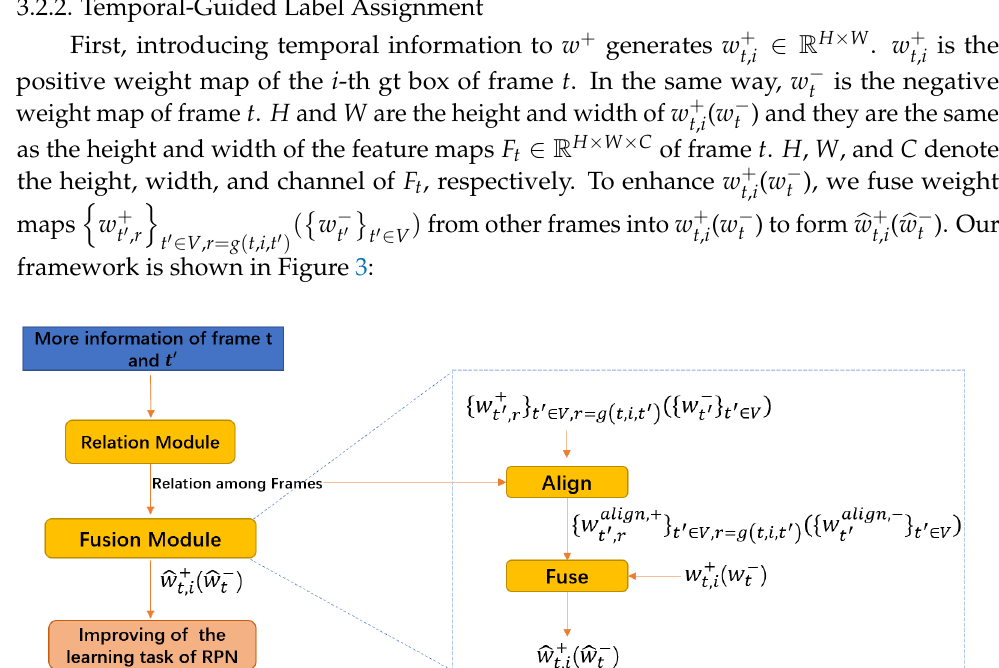
( (cid:98) w − ) act on the learning task of the region proposal t t , i